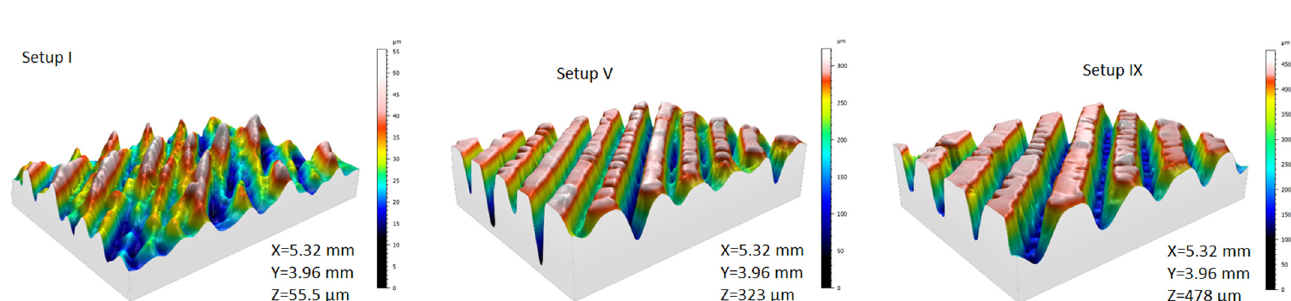
Figure 5. Scanned FDM surfaces for setup I ( left ), setup V ( center ), and setup IX ( right ).